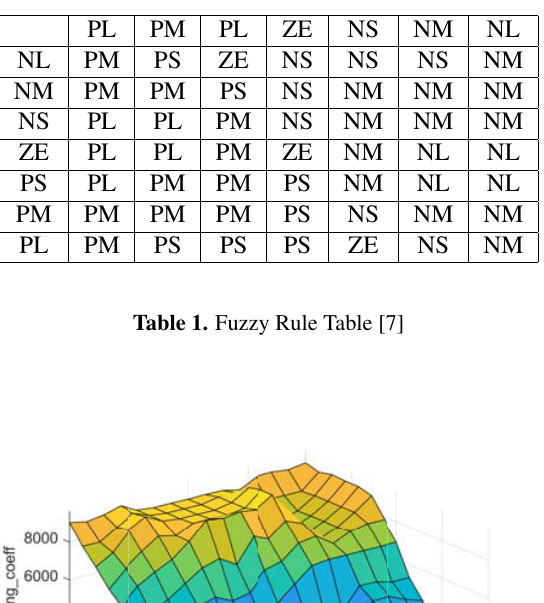
A membership function is a fuzzy set with pre defined range of 0 to 1 as shown in Fig 4,5 and 6, Fig. 7. explains the output surface of the proposed fuzzy system.